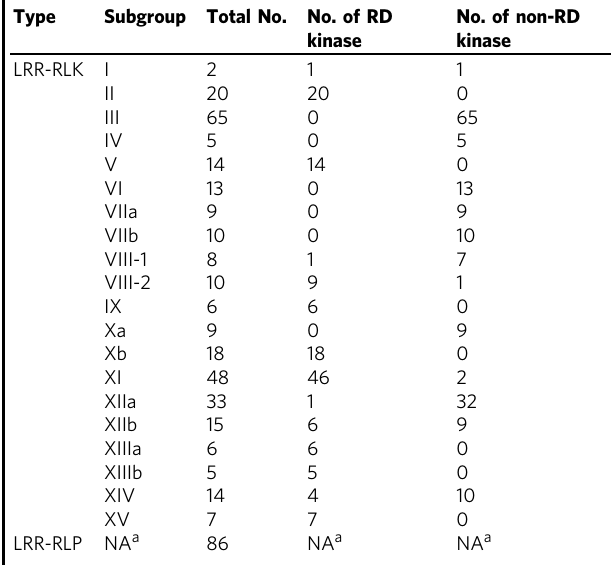
Table 1 LRR-RLPs and subgroup of LRR-RLKs in N.